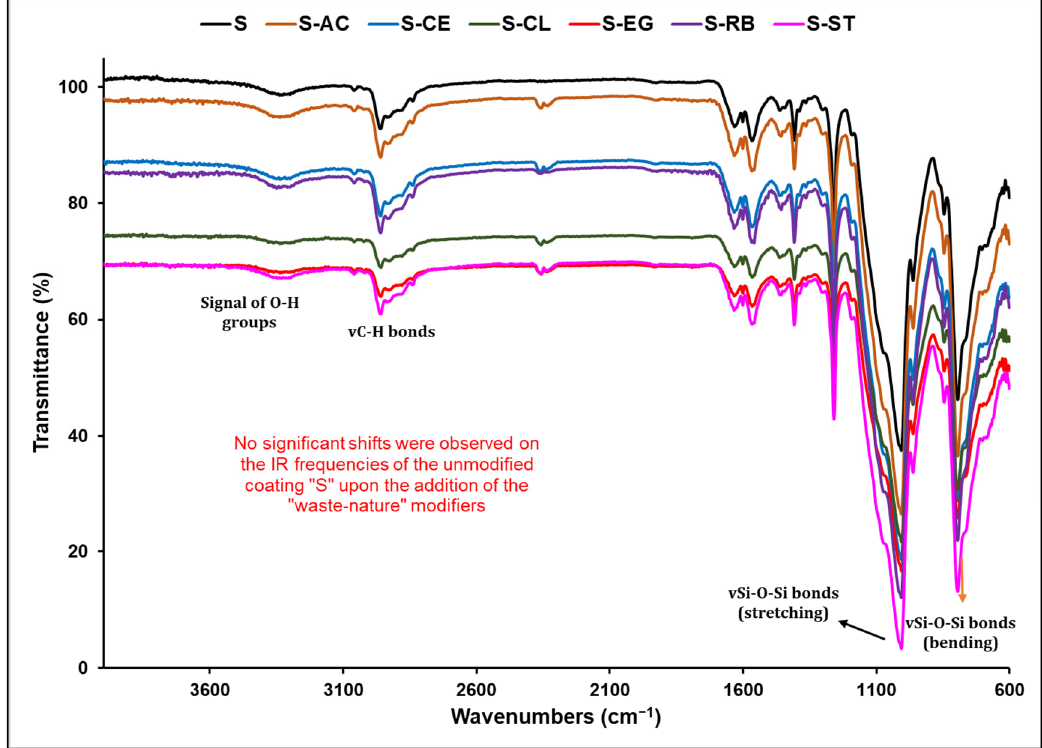
Figure 3. FTIR spectra of the unmodified and waste-material-modified hybrid sol–gel polymers.